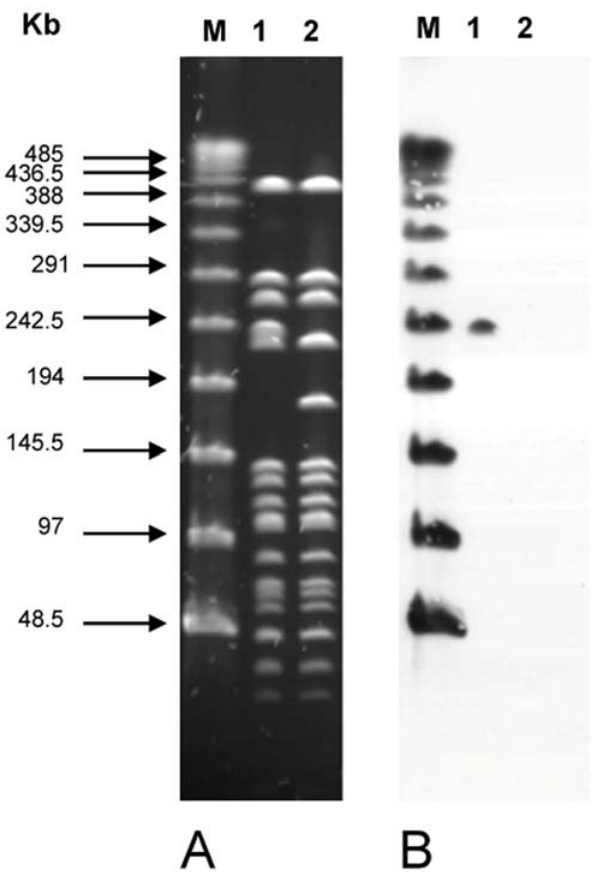
Figure 2. Mobilization of ACME in S.epidermidis 1457 by CcrAB. (A) Pulsed-field gel electrophoresis after Sma I restriction of chromo- somal DNA, for the parental strain S. epidermidis 1457 (lane 1) and its ACME excision mutant (lane 2). M=Lambda ladder, and (B) hybridiza- tion of Sma I restriction patterns of strain 1457 (lane 1) and its ACME excision mutant (lane 2) with a DNA probe for ACME ( arcCB ).